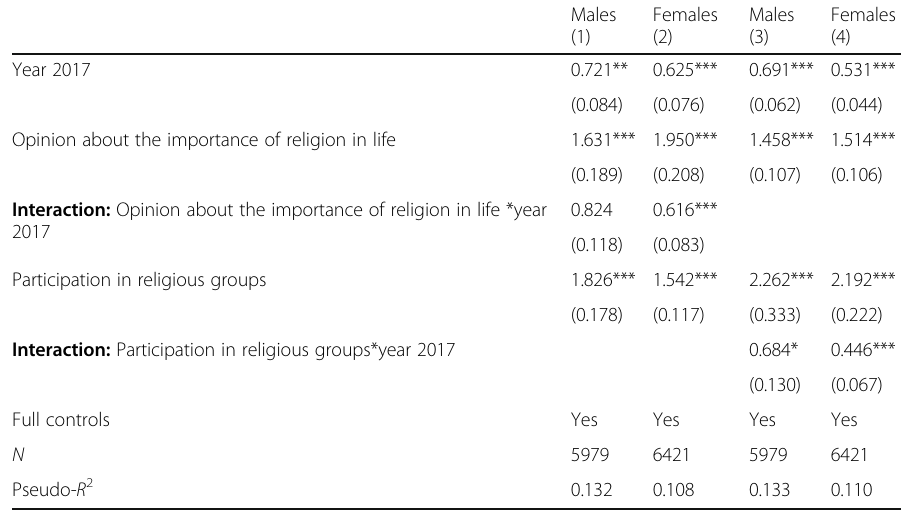
Table 3 Religiosity and virginity status over time, odds